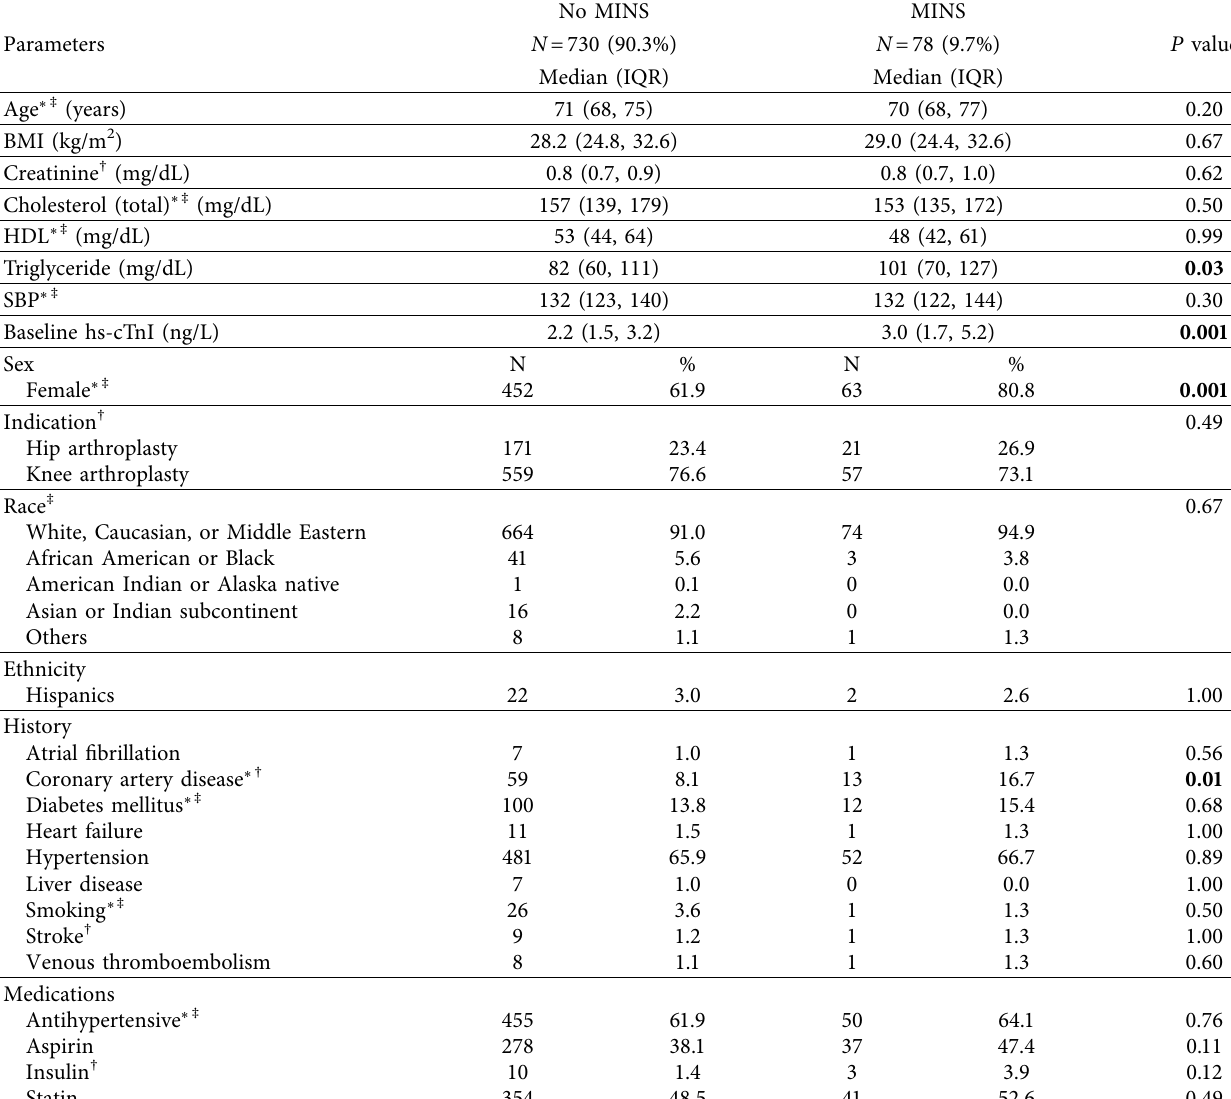
Table 1: Baseline demographic and clinical factors, stratified by myocardial injury on postoperative day (POD) 2.